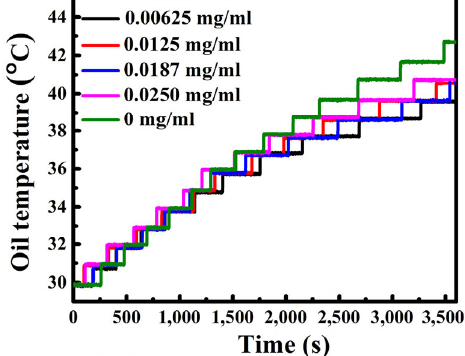
Fig. 8 Variation in oil temperature of different nano-oil concentrations with time.